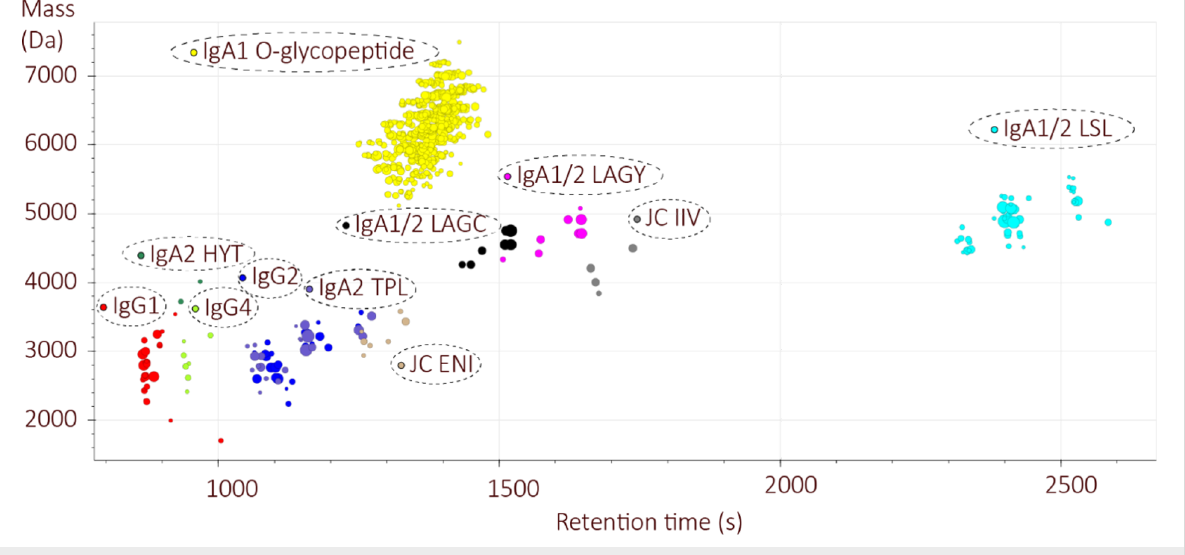
Figure 2: Representative IgG and IgA glycopeptide clusters detected by GlycopeptideGraphMS.